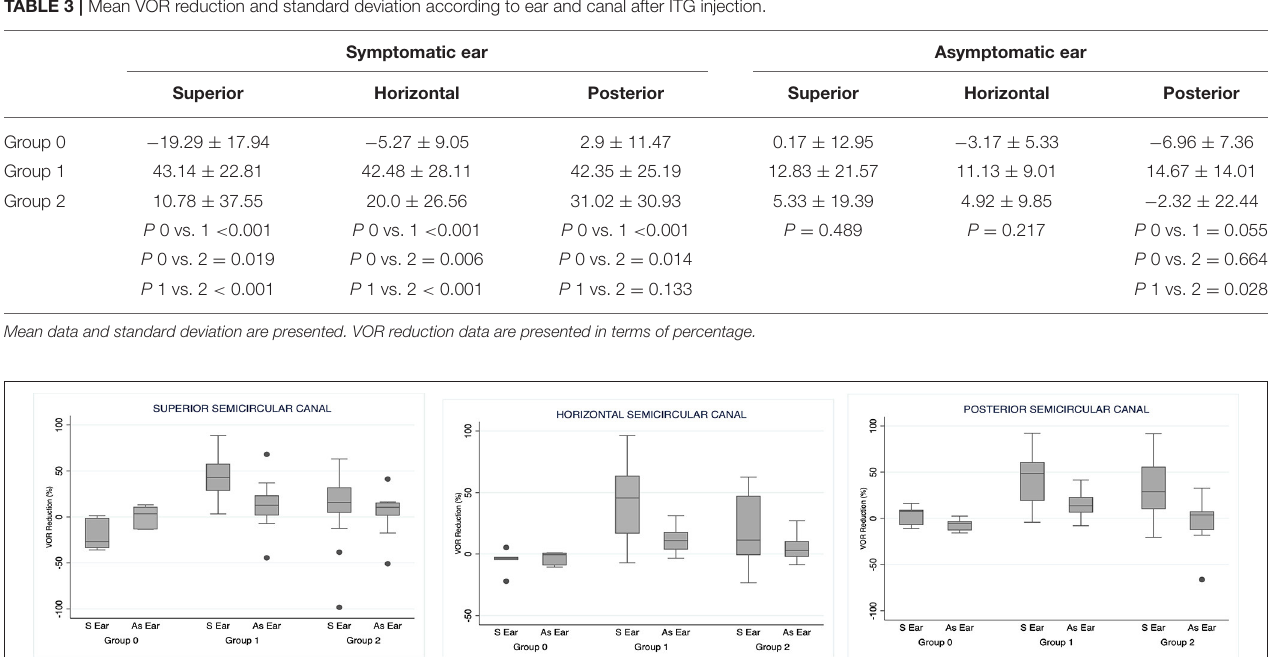
TABLE 3 | Mean VOR reduction and standard deviation according to ear and canal after ITG